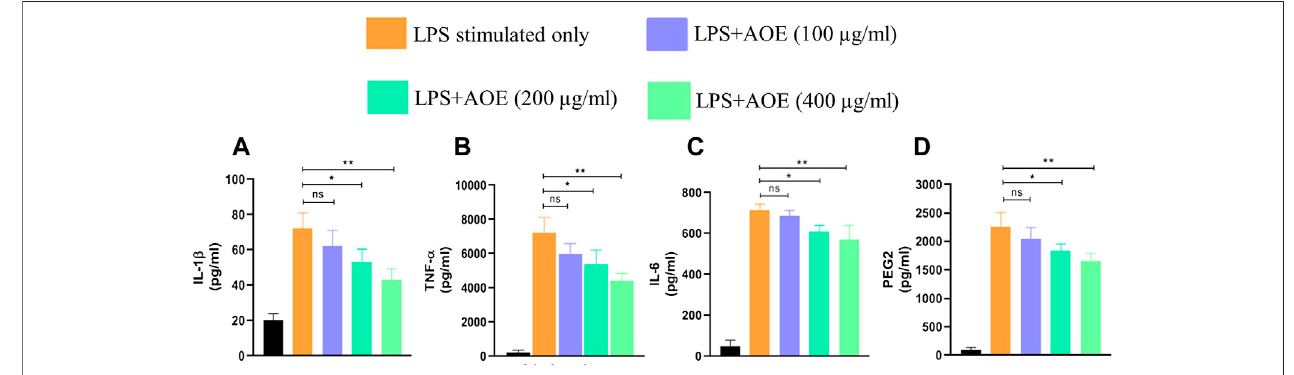
FIGURE 5 | Potential of AOE in de fl ating the LPS-mediated in fl ammatory response as characterized by the levels of (A) IL-1 β , (B) TNF- α , (C) IL-6, and (D) PGE2 withinJ774A.1. .Datacommunicatedconstitutethemean±SEMofindividualexperiments performedthriceintriplicates.Thelevel ofsigni fi cance amongdifferentAOE- treated groups was determined using one-way ANOVA and Dunnett ’ s post-hoc in comparison with untreated control where *represents p < 0.05 and ** p <